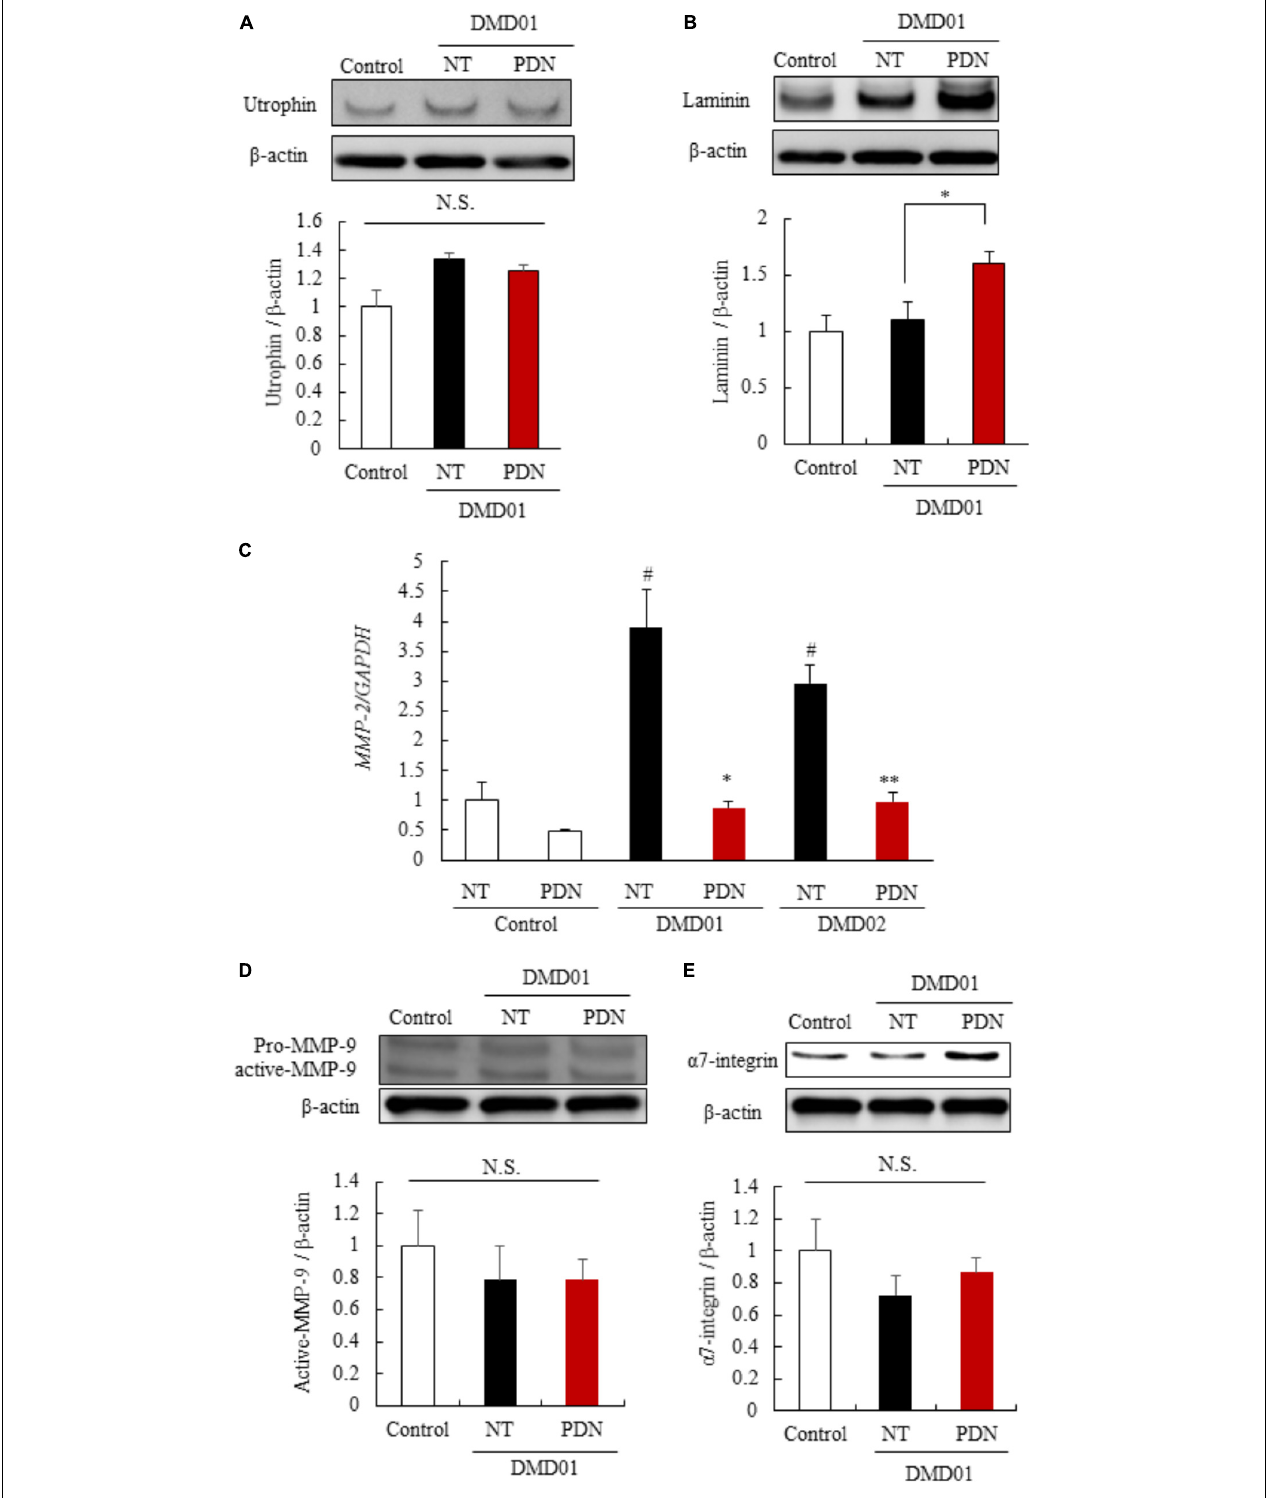
FIGURE 5 | Mechanisms of the efficacy of prednisolone in DMD pathology. (A) Western blot analysis of utrophin in myotubes from control individual (Ctrl), NT, and PDN. (B) Western blot analysis of laminin in Ctrl, NT, and PDN. (C) Quantitative RT-PCR analysis of MMP -2 in Ctrl, NT, and PDN. (D) Western blot analysis of MMP-9 in Ctrl, NT, and PDN. (E) Western blot analysis of α 7 integrin in Ctrl, NT, and PDN. Data in Figure are shown as means ± SEM ( n = 3). # p < 0.05 vs. Ctrl, ∗∗ p < 0.01, ∗ p < 0.05 vs. NT (Student’s t -test).